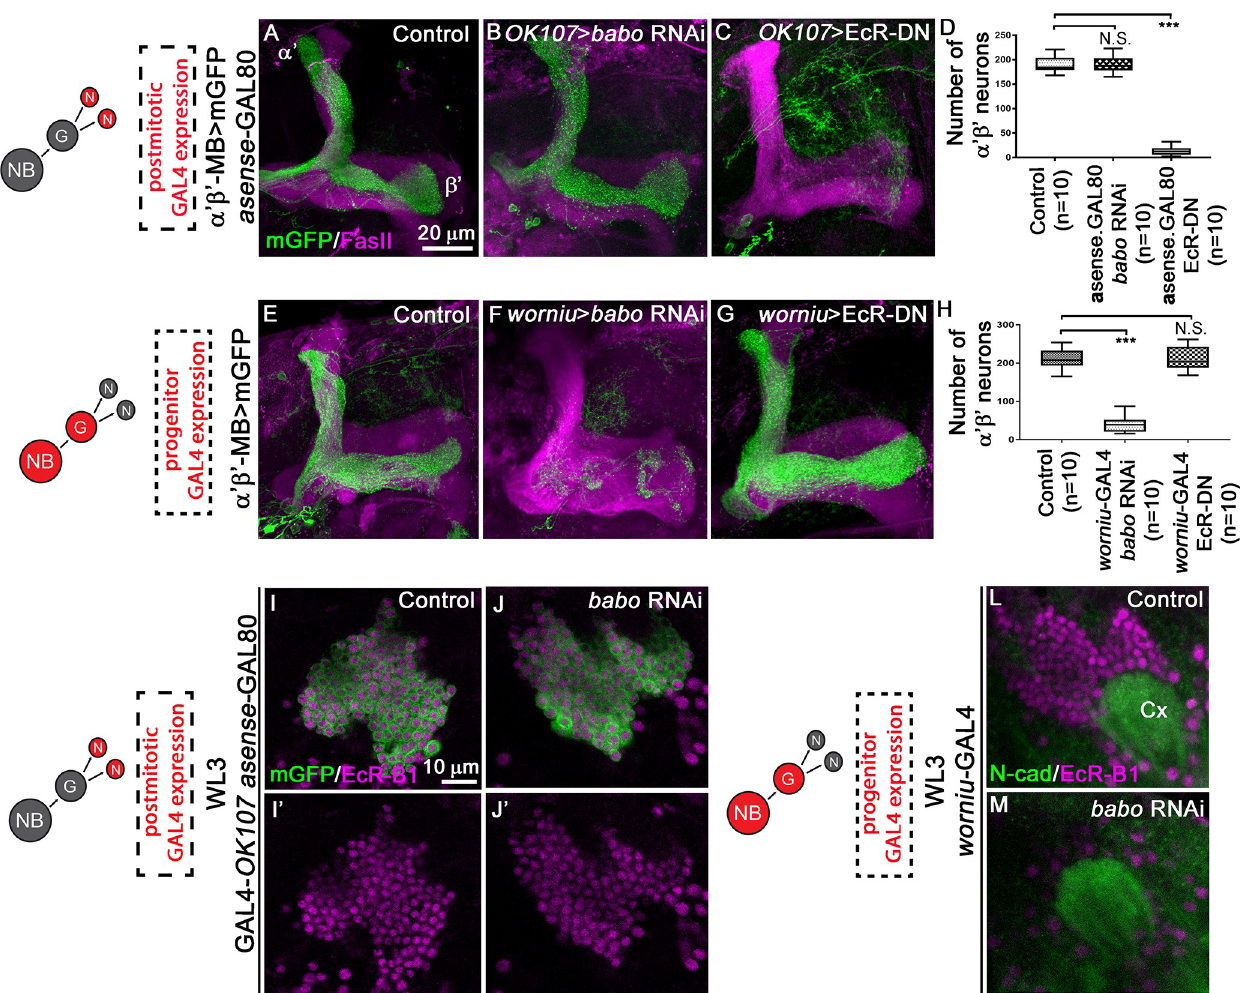
Fig 4. TGF- β signalling is required in MB progenitors to control EcR-B1 expression during consolidation of α ’ β ’ MB fate. (A-C) Adult MB lobes from control (A), OK107 > babo RNAi asense > GAL80 (B), and OK107 > EcR-DN asense > GAL80 (C) brains stained with anti-FasII antibody (magenta). Green: GMR26E01 - LexA- α ’ β ’ - MB-driven mGFP in A-C. (D) Quantification of the number of adult α ’ β ’ MB neuron cell bodies from control, OK107 > babo RNAi asense > GAL80 and OK107 > EcR-DN asense > GAL80 brains. Statistical comparison to the control: N.S. Not Significant; ��� , p < 0.001 (two tailed t test). (E-G) Adult MB lobes from control (E), worniu > babo RNAi (F), and worniu > EcR-DN (G) brains stained with anti-FasII antibody (magenta). Green: GMR26E01 - LexA- α ’ β ’ - MB-driven mGFP in E-G. (H) Quantification of number of adult α ’ β ’ MB neuron cell bodies from control, worniu > babo RNAi and worniu > EcR-DN brains. Statistical comparison to the control: N.S. Not Significant; ��� , p < 0.001 (two tailed t test). (I-J’) WL3 MB cell bodies from control (I,I’) and OK107 > babo RNAi asense > GAL80 (J, J’) brains stained with anti-EcR-B1 antibody (magenta). Green: GAL4- OK107 -driven mGFP in I-J’. (L-M) WL3 MB cell bodies from control (L) and worniu > babo RNAi (M) brains stained with anti-EcR-B1 antibody (magenta). Anti-N-cadherin (green) staining was used as landmark in locating MB neurons. Cx, MB Calyx. NB, neuroblast; G, ganglion mother cell; N, neurons.